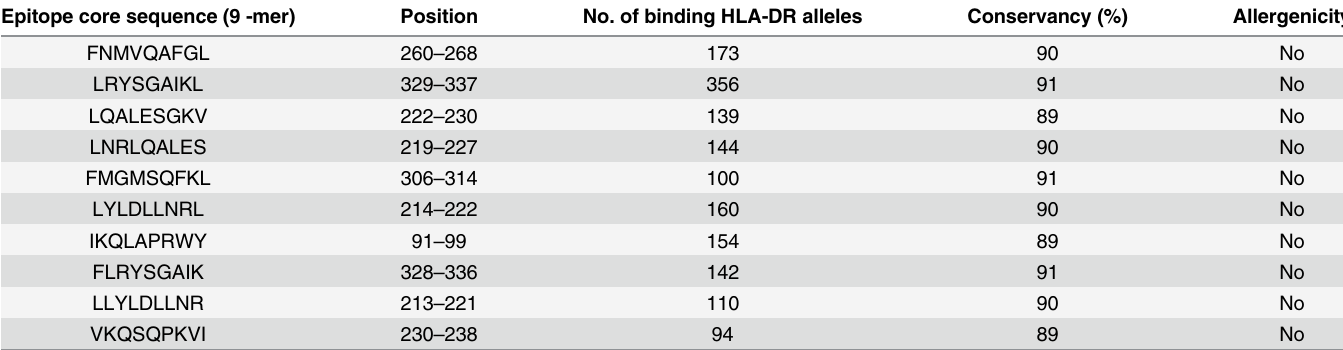
Table 4. Helper T-cell epitopes of the N protein of MERS-CoV selected on the basis of maximum HLA binding alleles. Epitope core sequence (9 -mer) Position No. of binding HLA-DR alleles Conservancy (%) Allergenicity FNMVQAFGL